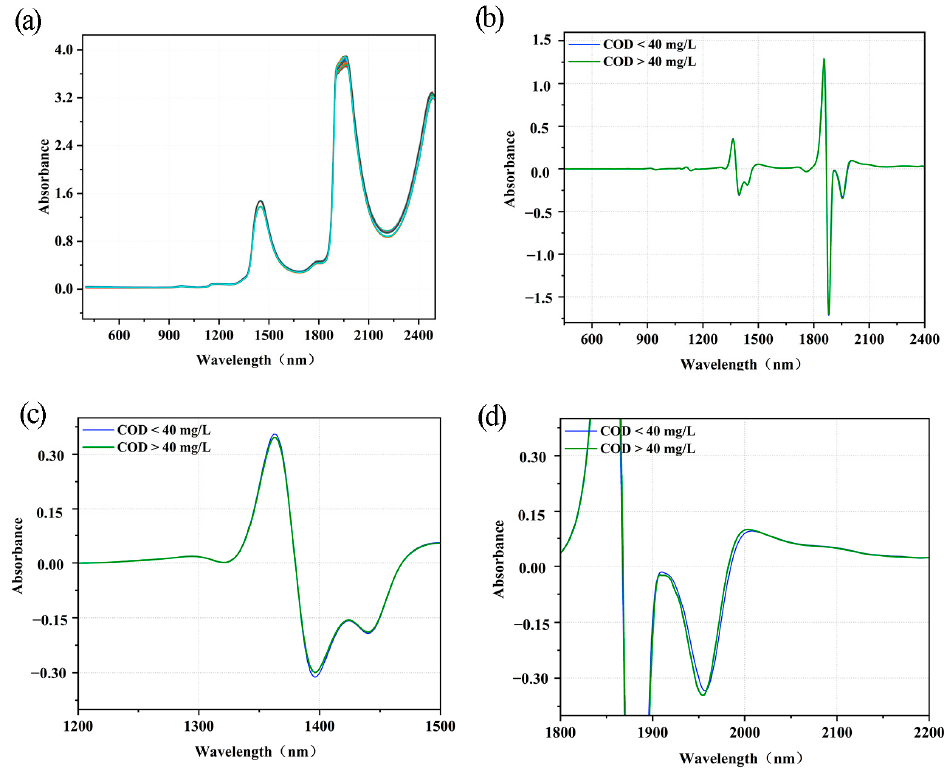
Figure 2. Visible near-infrared spectroscopy plots of surface water samples: ( a ) raw spectra; ( b ) sec-